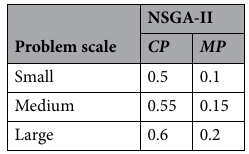
Table 6. Parameter settings of NSGA-II in different-scale